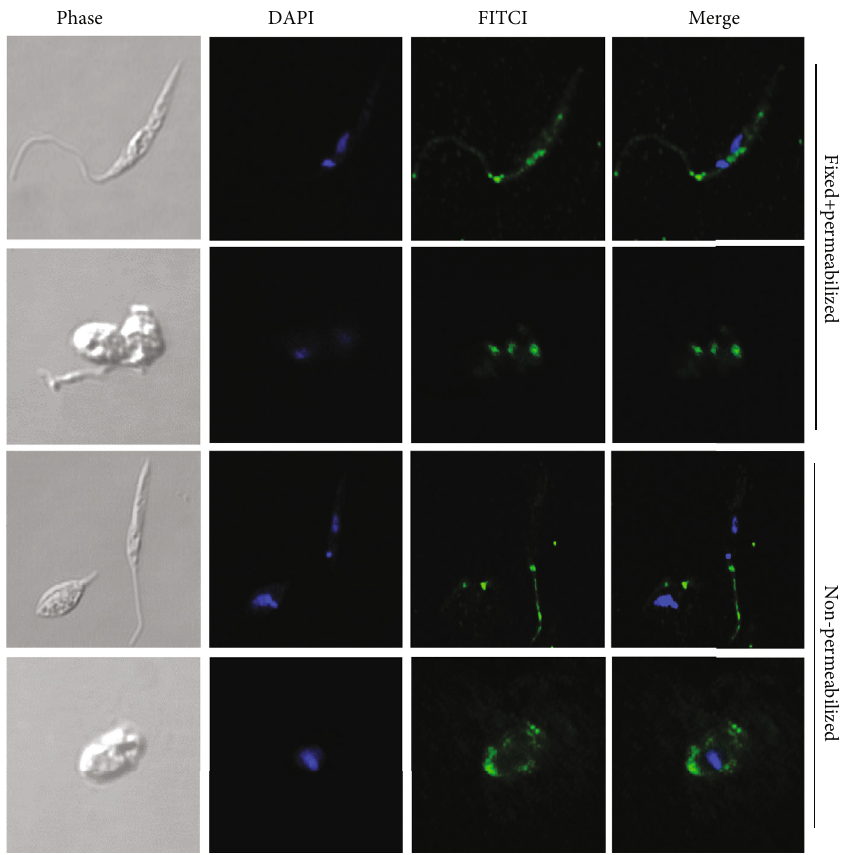
Figure 2: Subcellular localization of LmxMBA protein in L. mexicana promastigotes and amastigotes. Immuno fl uorescence microscopy utilizing serum anti-LmxMBA and secondary antibody coupled to FITC; nucleus and kinetoplast were marked with DAPI.